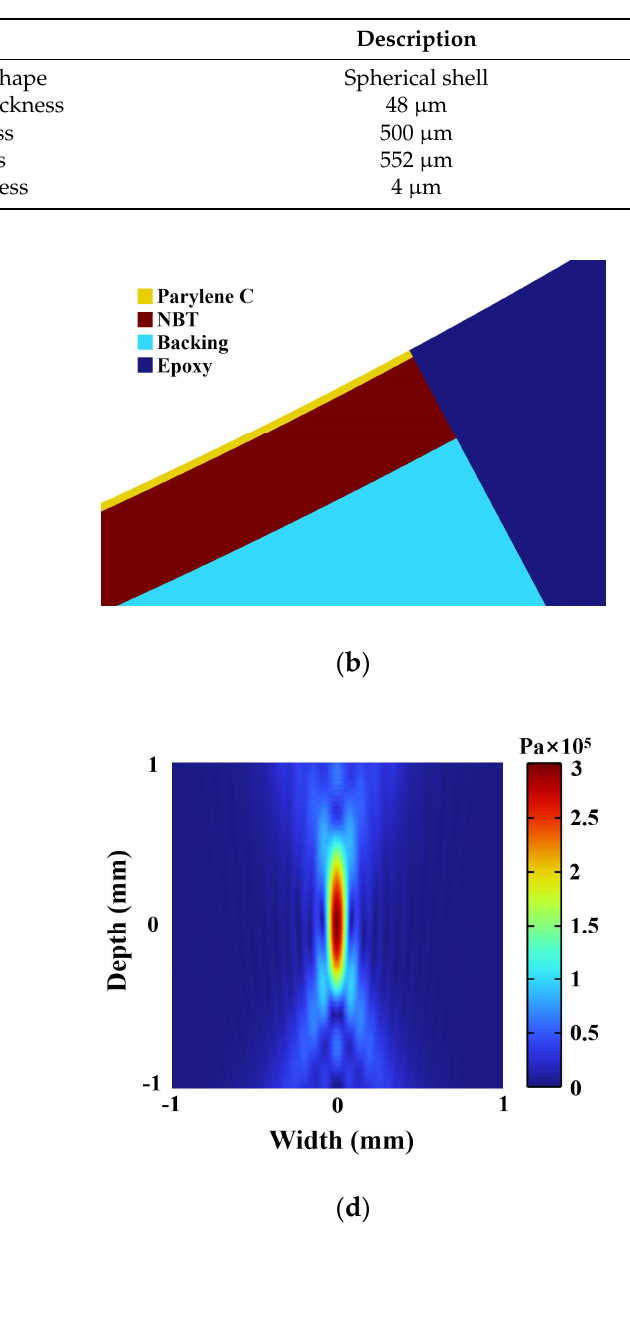
Table 4. The finite element model parameters of the transducer.